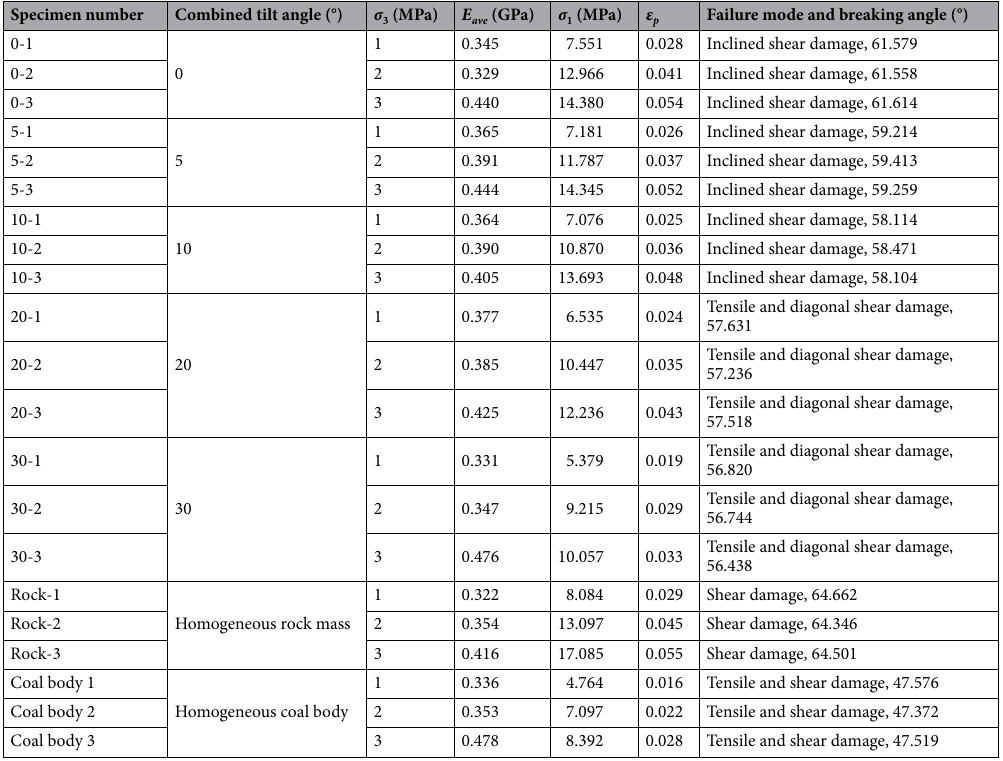
Table 1. Physical and mechanical parameters of coal–rock